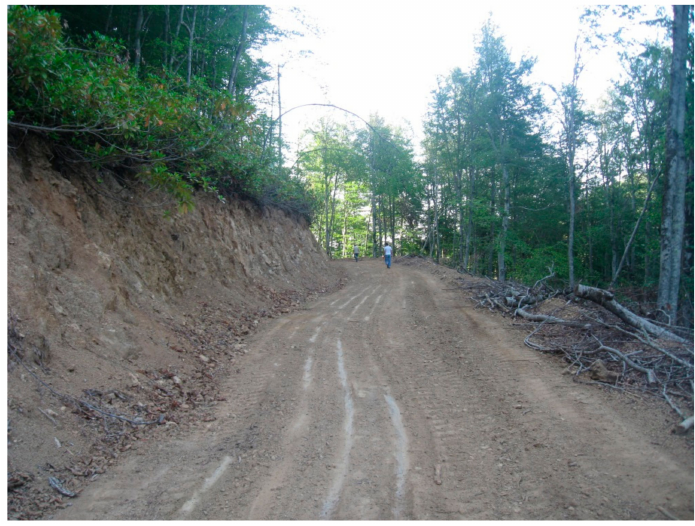
Figure 1. Forest road in study